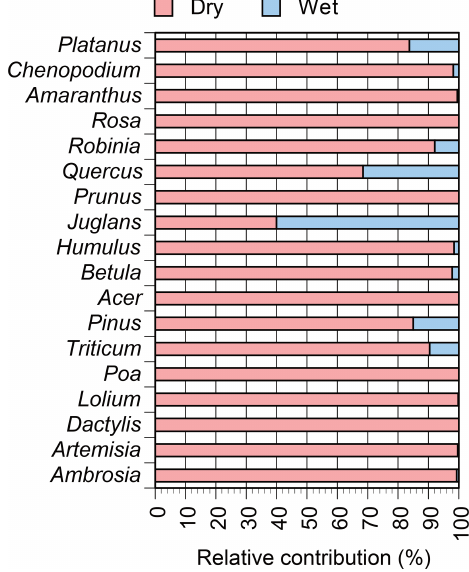
Figure 5. Relative contributions of dry and wet deposition for the selected plant genera with known allergenic species. Genera in Ta- ble 2 are shown, with information regarding allergenic species avail- able in Table 1.